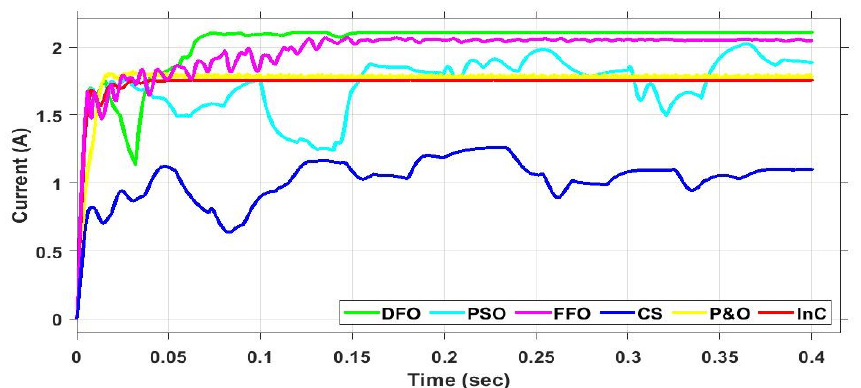
Figure 29. PS2 current comparison between all algorithms for MLPE Distributed PV system.